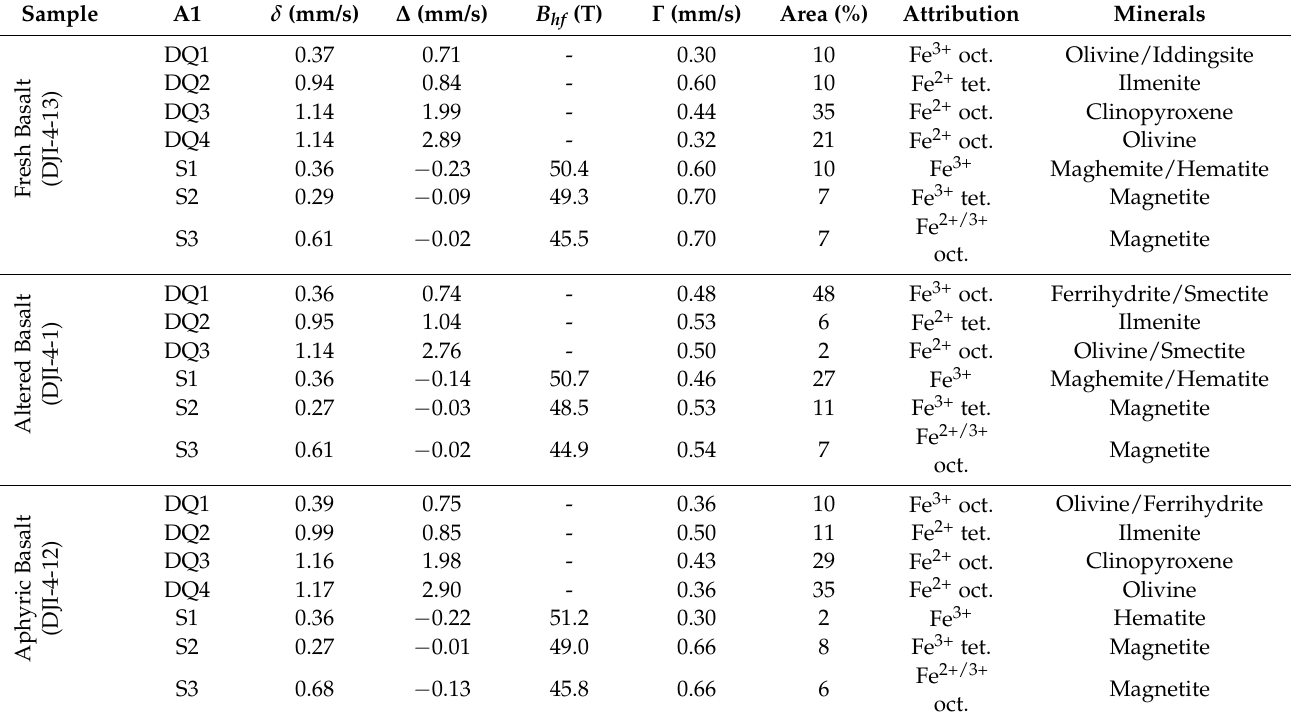
Table 6. Mössbauer spectroscopy from 57 Fe analysis of site 4 samples: fresh basalt, altered basalt, and aphyric